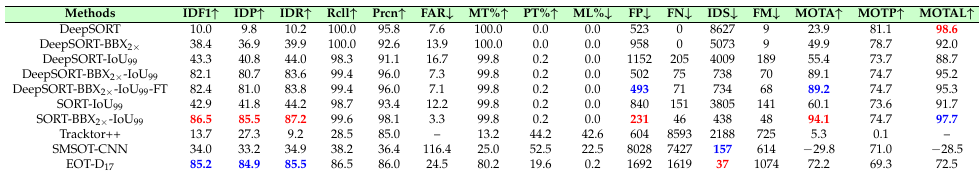
Table 7. Results of DeepSORT, SORT, Tracktor++, and SMSOT-CNN on the KIT AIS pedestrian dataset. The first and second best values are